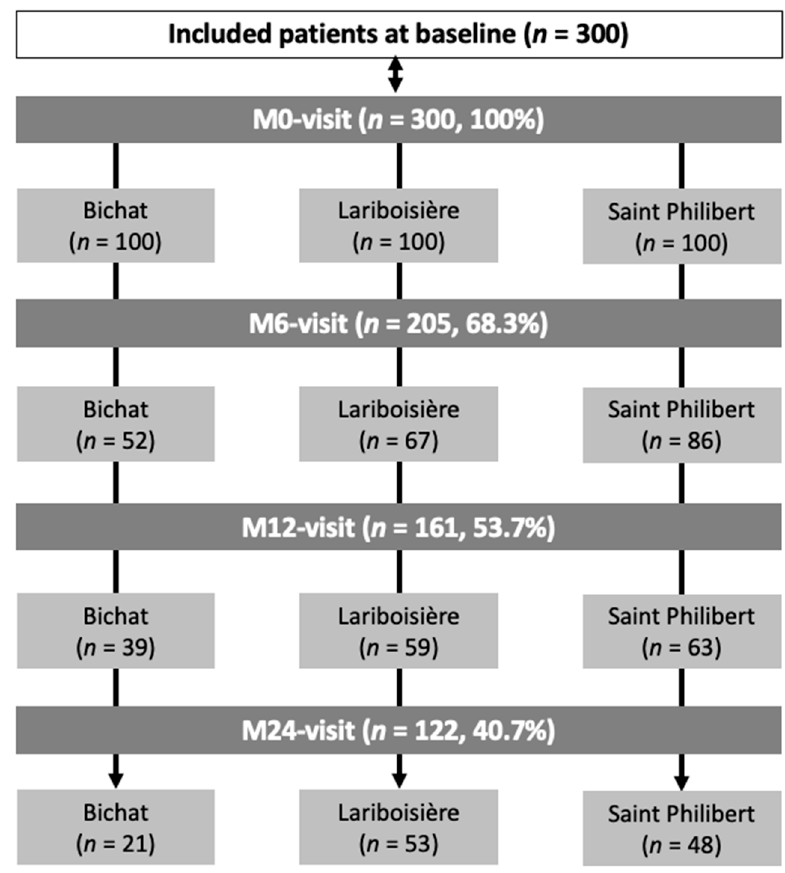
Figure 1. Study flow chart. M: month.